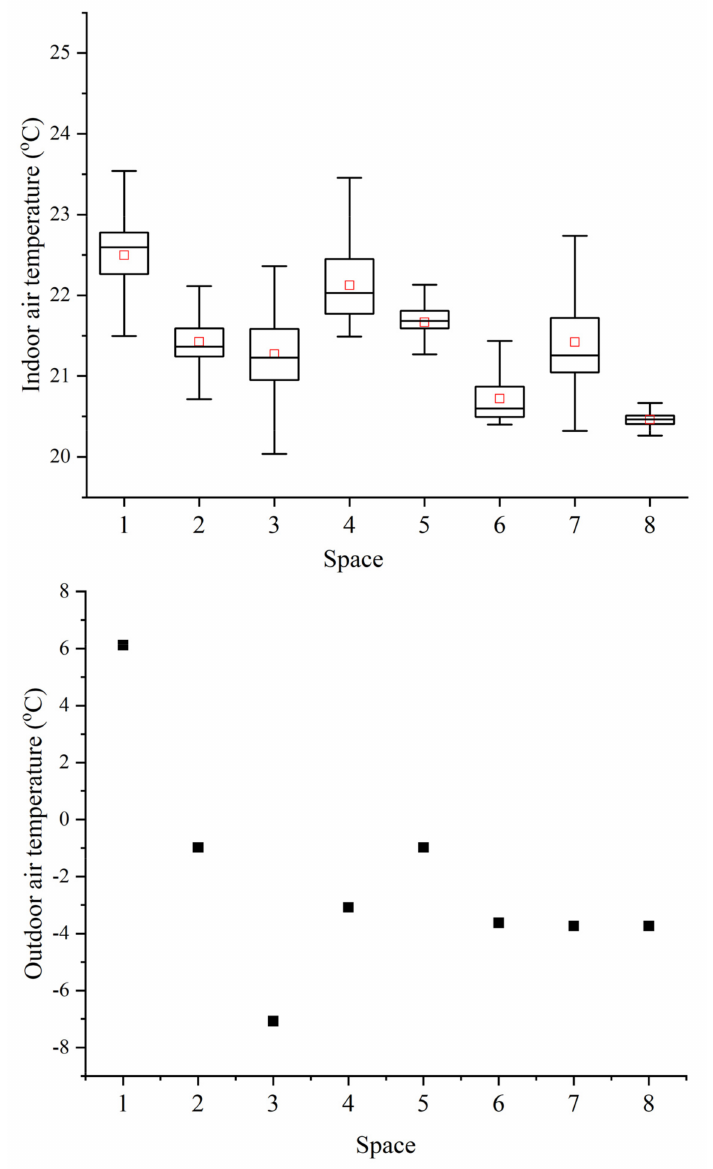
Figure 7. Measured indoor air temperature distribution in the studied eight spaces and outdoor air temperature during the measurement